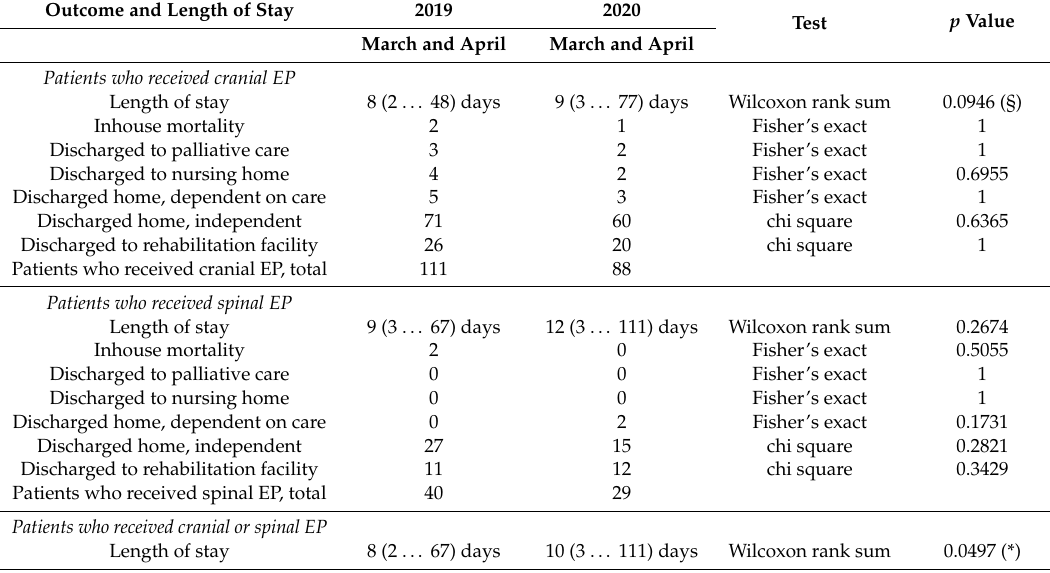
Table 3. Outcome and length of hospital stay of patients who received elective procedures at our department in March and April 2020 as compared to March and April